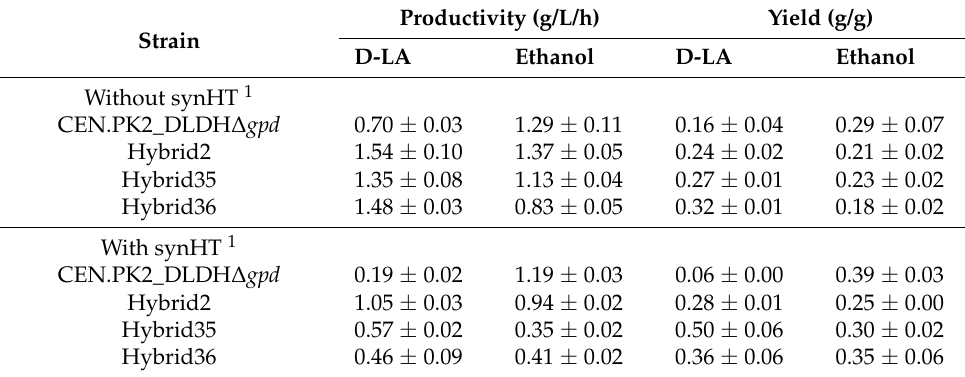
Table 2. D-lactic acid (D-LA) productivity and yield in batch fermentation using glucose as a sole carbon source.